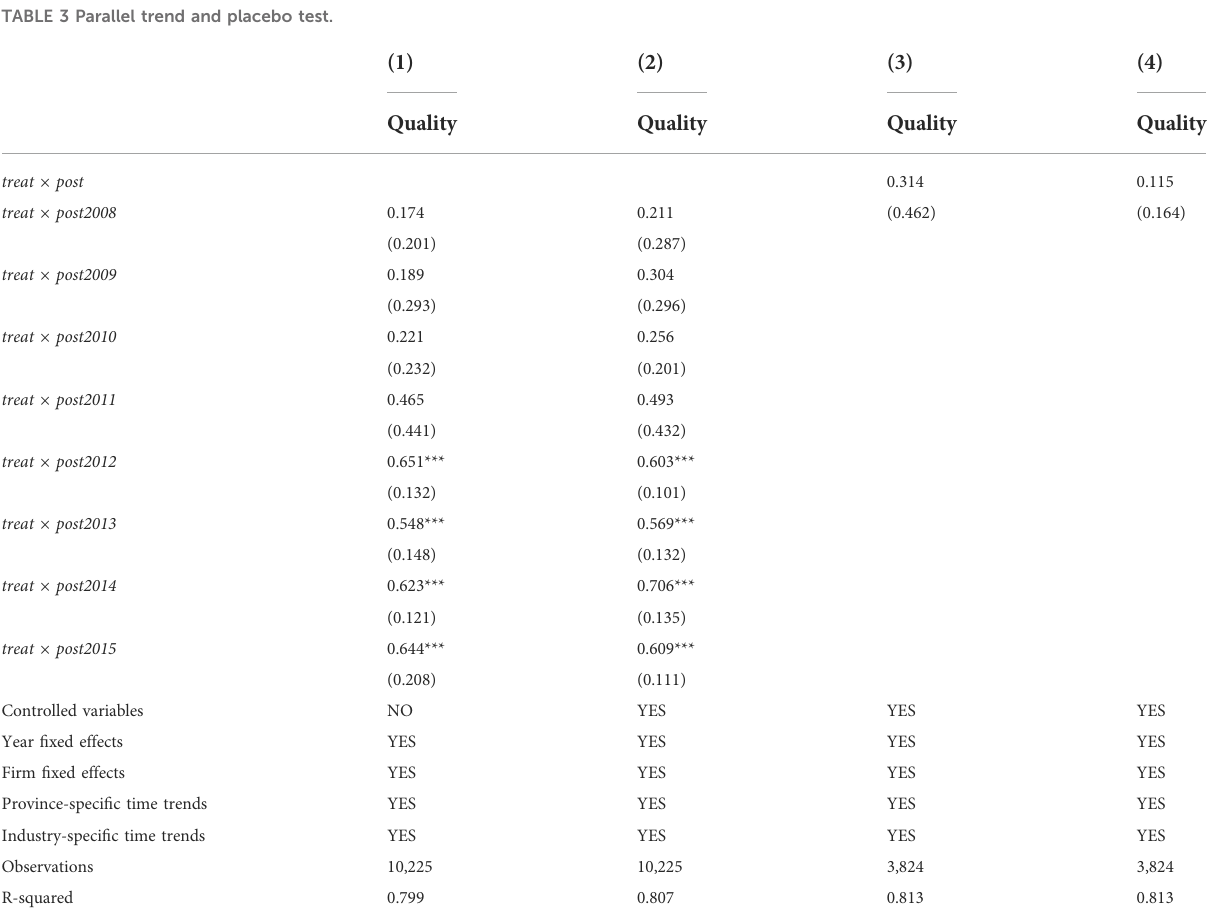
TABLE 3 Parallel trend and placebo test.